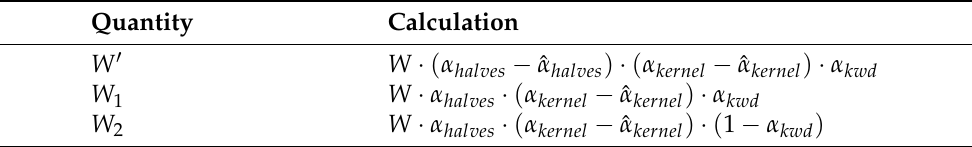
Figure 2. Halves by product flow. Table 1. Halves by product flow branch